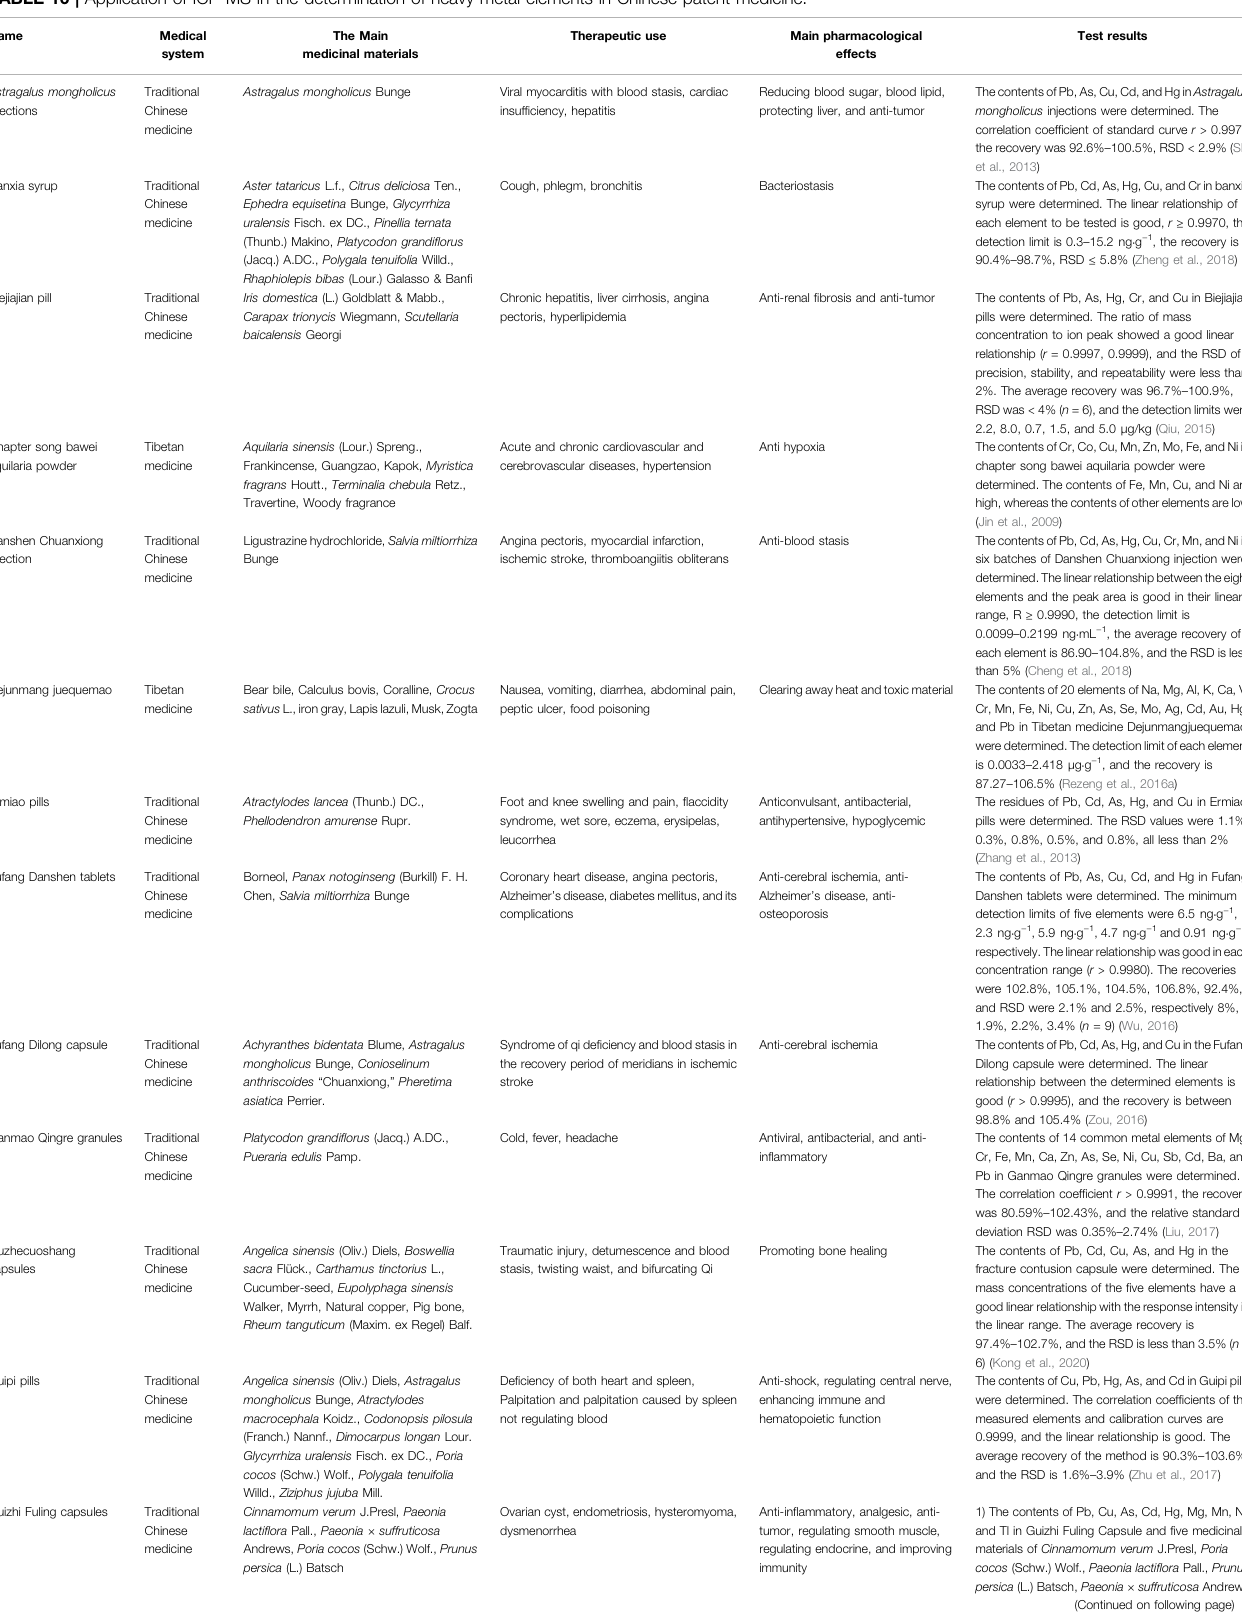
TABLE 10 | Application of ICP-MS in the determination of heavy metal elements in Chinese patent